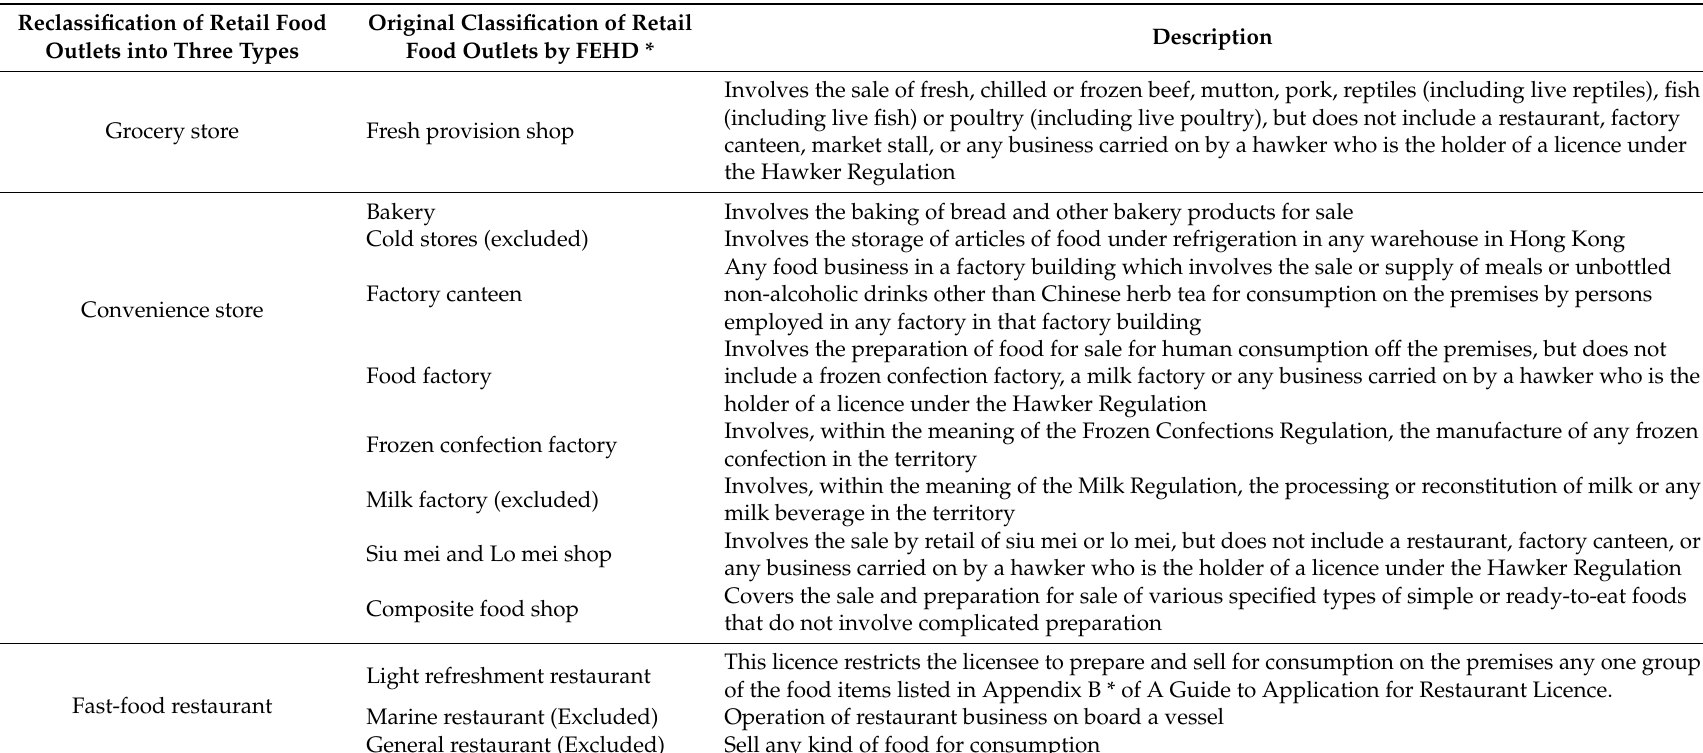
Table 1. Reclassification of retail food outlets into three types derived from